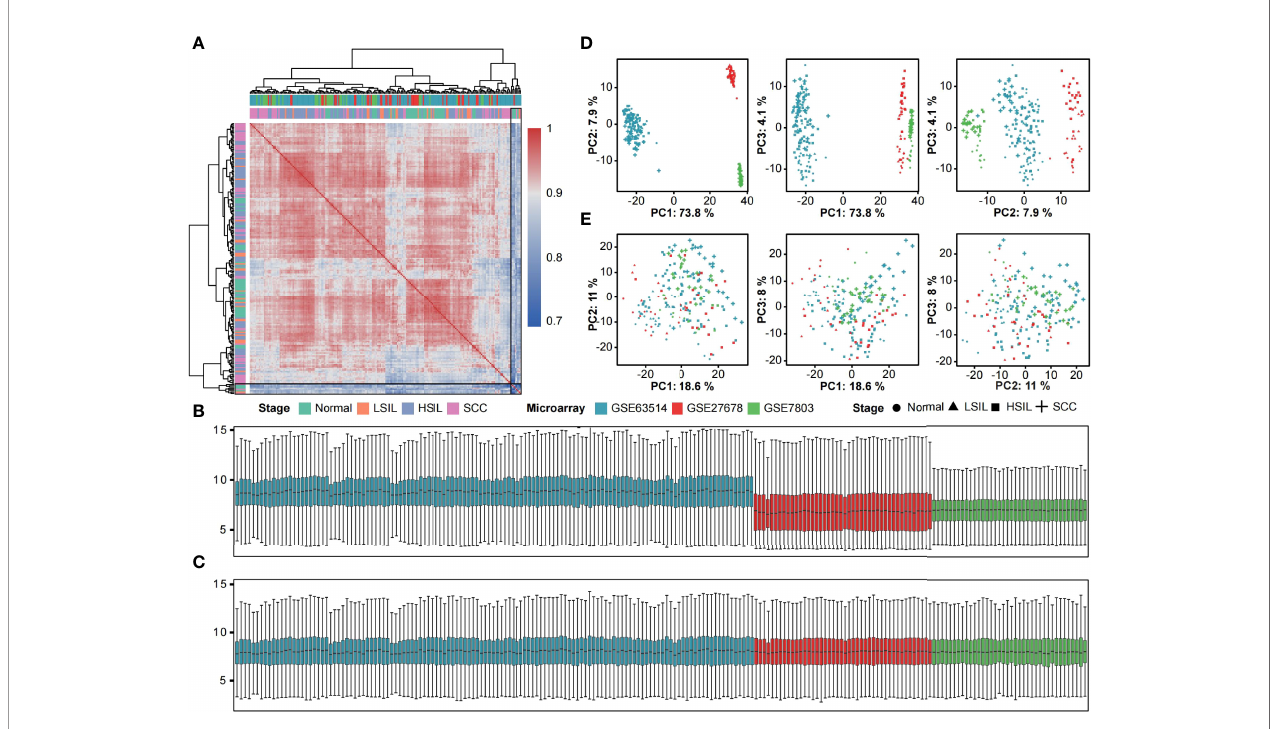
FIGURE 1 | Removal of outliers and batch effect. (A) Heatmap displaying Pearson correlations between pairwise comparisons of meta-dataset. Clear outliers are highlighted with a black frame. Boxplots of log2-transformed gene expression distributions before (B) and after (C) batch effect correction. The boxes are colored according to datasets. Scatter plots of the fi rst three principal components from the PCA of expression data before (D) and after (E) batch effect correction. Symbols are colored according to datasets and shaped according to disease